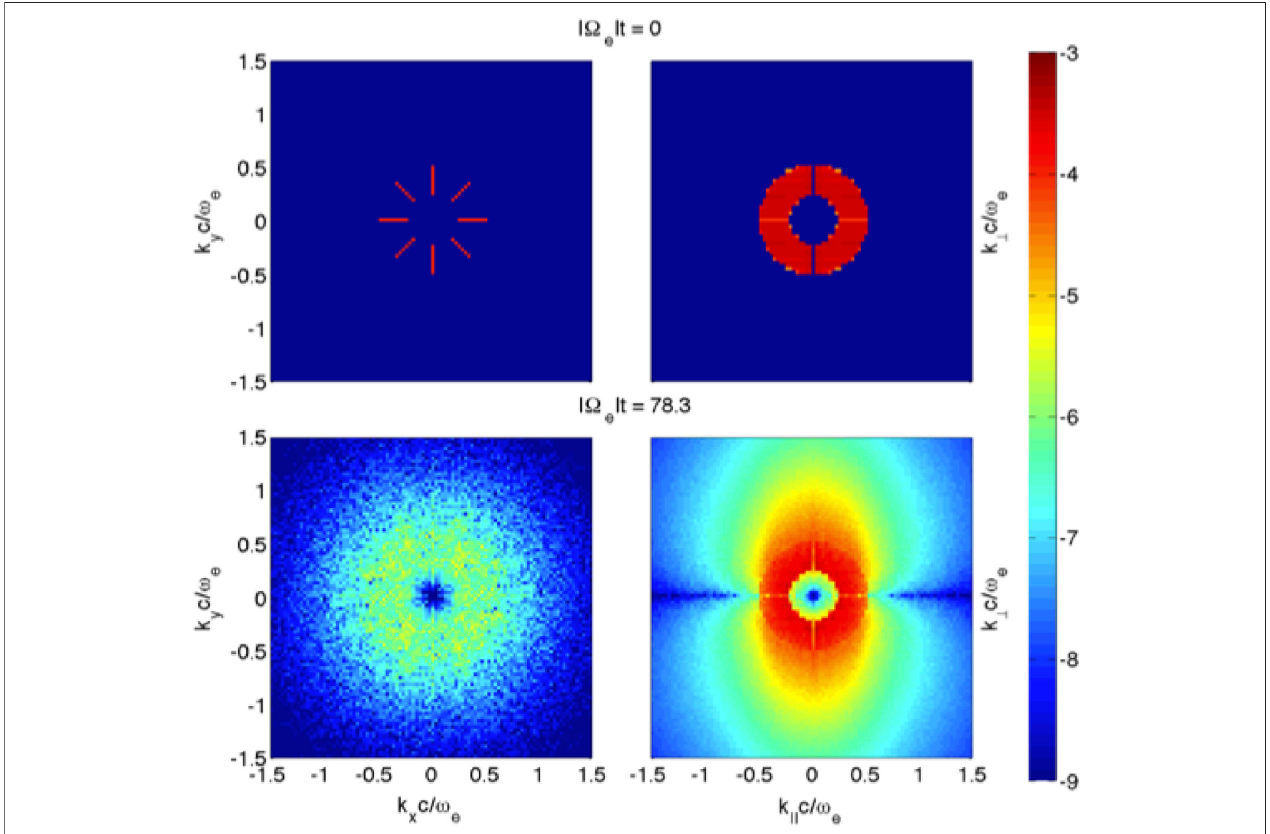
FIGURE 2 | 3D PIC simulations of whistler turbulence cascade. Simulation domain: 2048 3 cells. Macro-particles: 2.75 × 10 11 /species. The plot shows magnetic energy wavevector spectra at two times: t = 0 (top) and t Ω e = 78.3 (bottom). Left column: k x − k y spectra cut at k (cid:1) = 0. Right column: k (cid:1) − k ⊥ spectra reduced over the azimuthal angle of the perpendicular wavevectors [45].